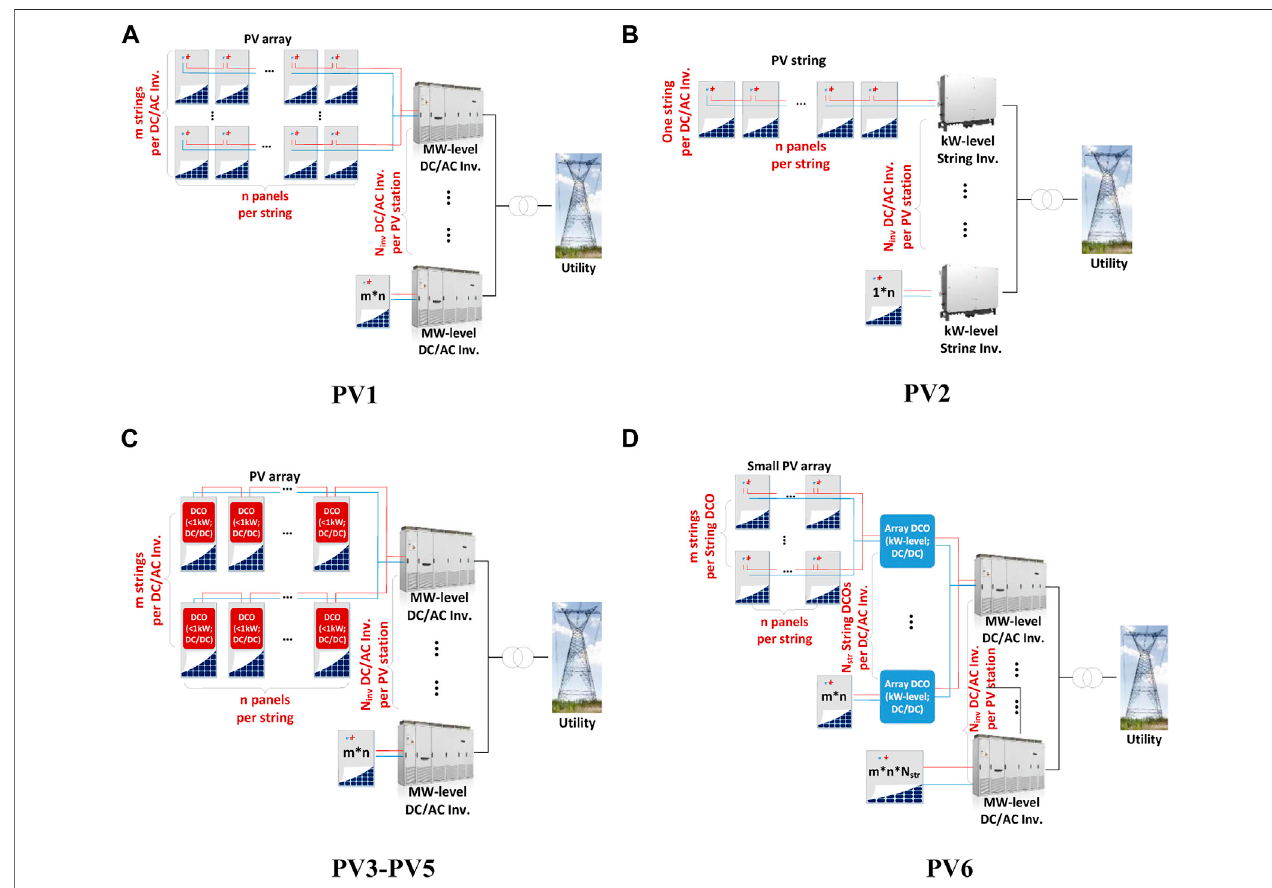
study, as shown in Figure 8 : PV1---PV plant with conventional array-level central inverters; PV2---PV plant with string-level inverters; PV3---PV plant with series-connected panel-level Boost DCOs and central inverters; PV4---PV plant with series-connected panel-level Buck DCOs and central inverters; PV5---PV plant with series-connected panel-level Boost-Buck DCOs and central inverters; and PV6---PV plant with small array-level Boost DCOs in parallel and central inverters.